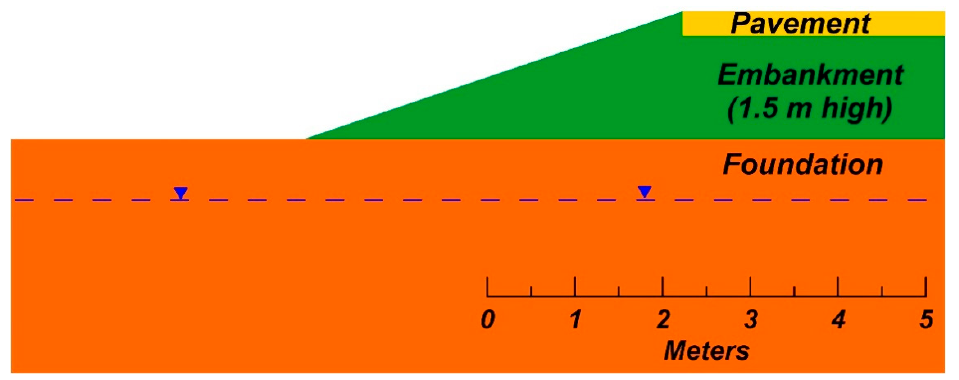
Figure 9. Cross-section of AL-5 at borehole B5.5. Table 3. Summary of shear strength parameters for slope stability